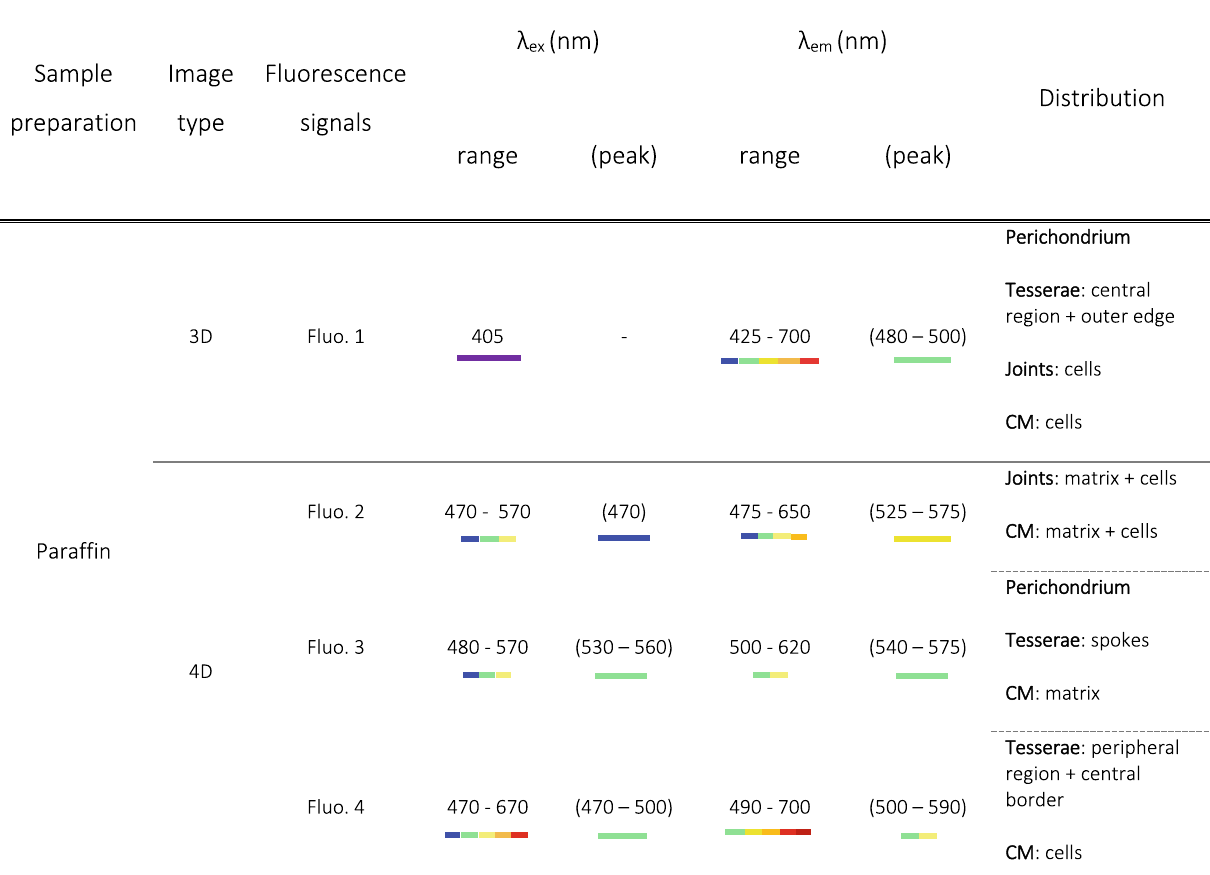
Table 2 Summary of excitation and emission wavelengths of each fluorescence signature and their tissue